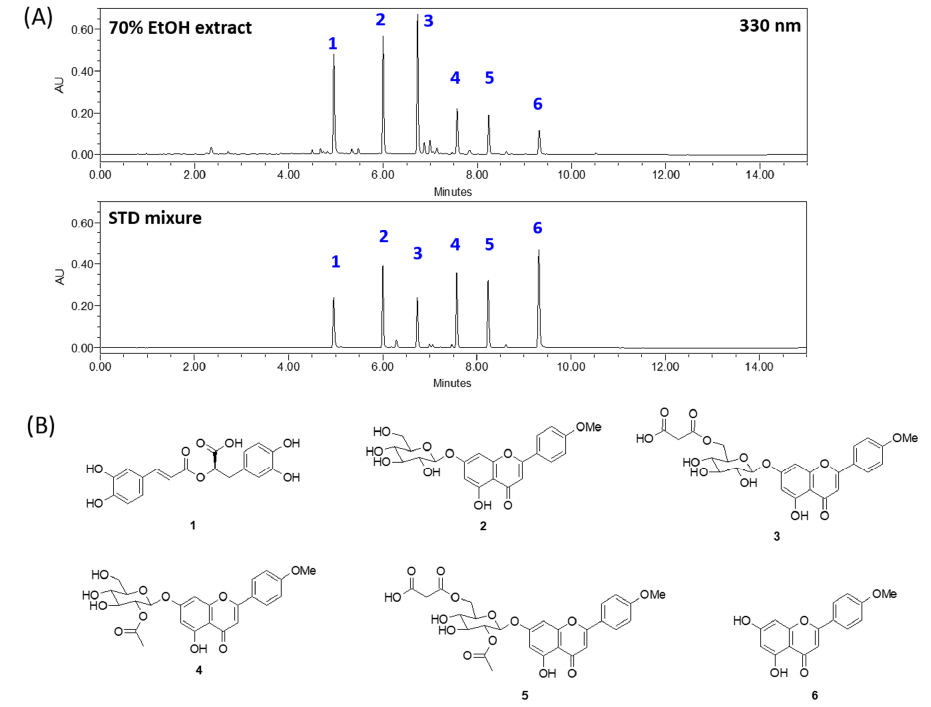
Figure 2. UPLC chromatogram of 70% EtOH A. rugosa ( A ) and chemical structures of six main components ( B